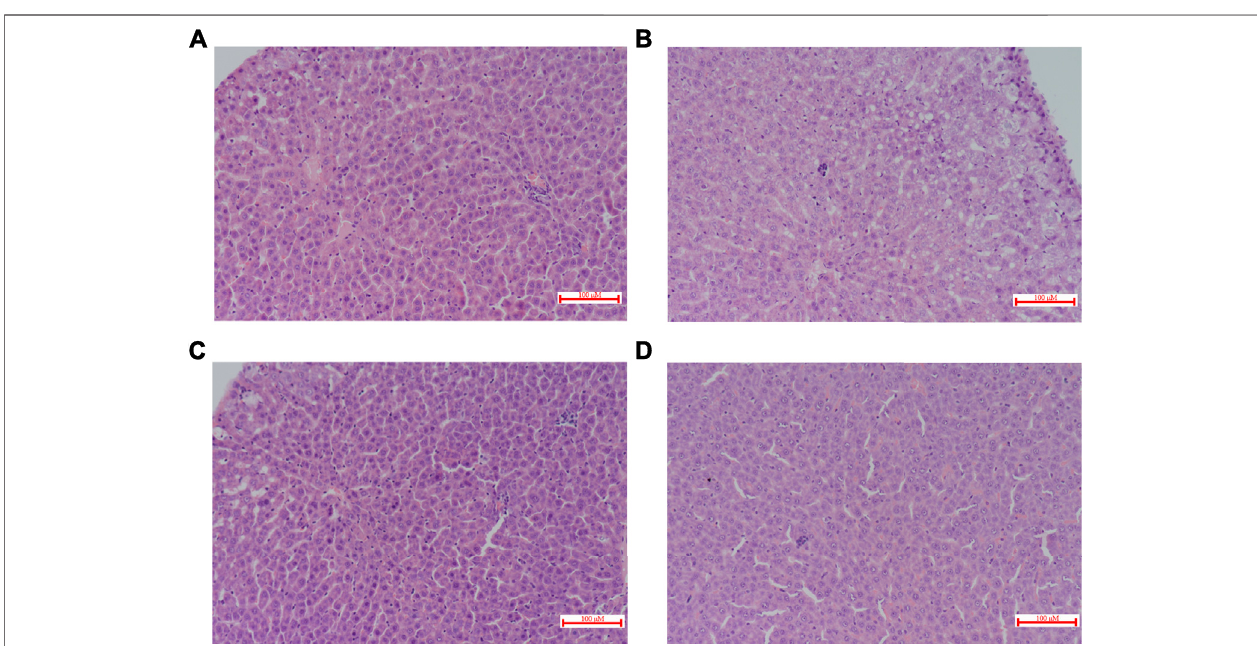
FIGURE 6 | Histopathological evaluation of rat livers 12 h after the administration of RSV in combination with CP (H&E staining, × 200). The liver sections (A) Single i.v. dose RSV + Multiple p.o. dose CP (Group I); (B) Single i.v. dose RSV + Multiple p.o. dose vehiclecontrol (Group II); (C) Single p.o. dose RSV + Multiple p.o. dose CP (Group Ⅲ ); (D) Single p.o. dose RSV + Multiple p.o. dose vehicle control (Group Ⅳ ). p.o. dose: p.o. administration as oral